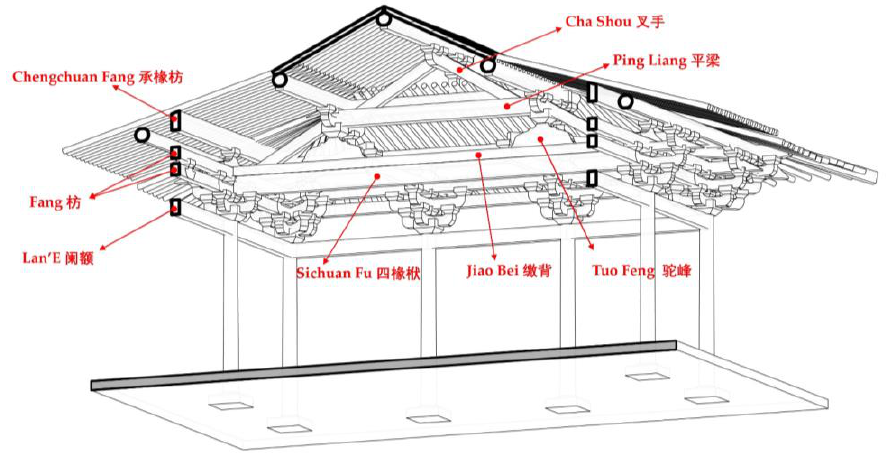
Figure 3. Sectional view of the Nanchan Temple (produced by the authors).